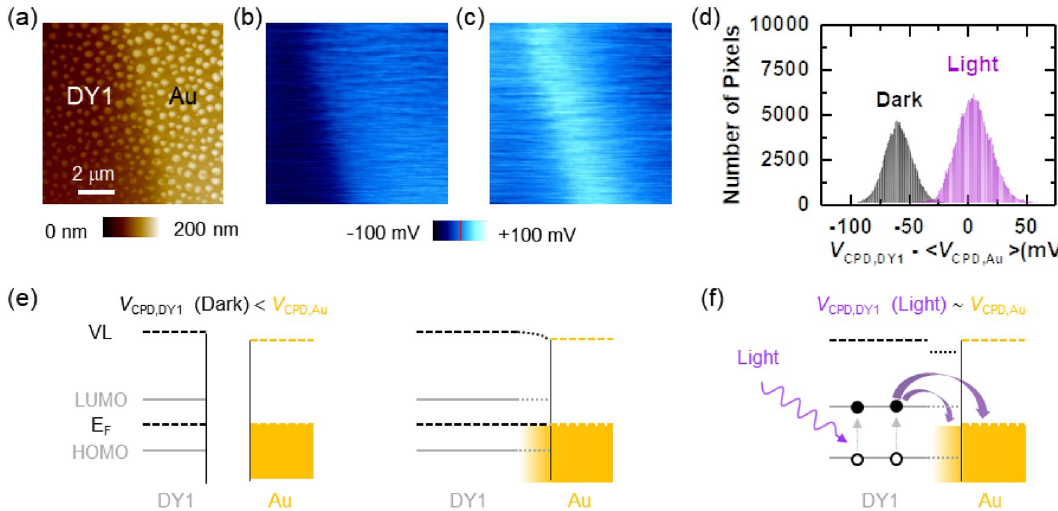
Figure 4. ( a ) AFM topographic image of DY1 and Au. V CPD,DY1 − <V CPD,Au > maps ( b ) in the dark and ( c ) under 405-nm light illumination at 8.28 mW/cm 2 . <V CPD,Au > corresponds to the average V CPD measured on the Au thin film. ( d ) Histogram of the number of pixels in the dark and light V CPD data. Proposed energy level alignments of ( e ) DY1 and Au before and after contact in the dark and ( f ) the DY1/Au interface under 405-nm illumination.